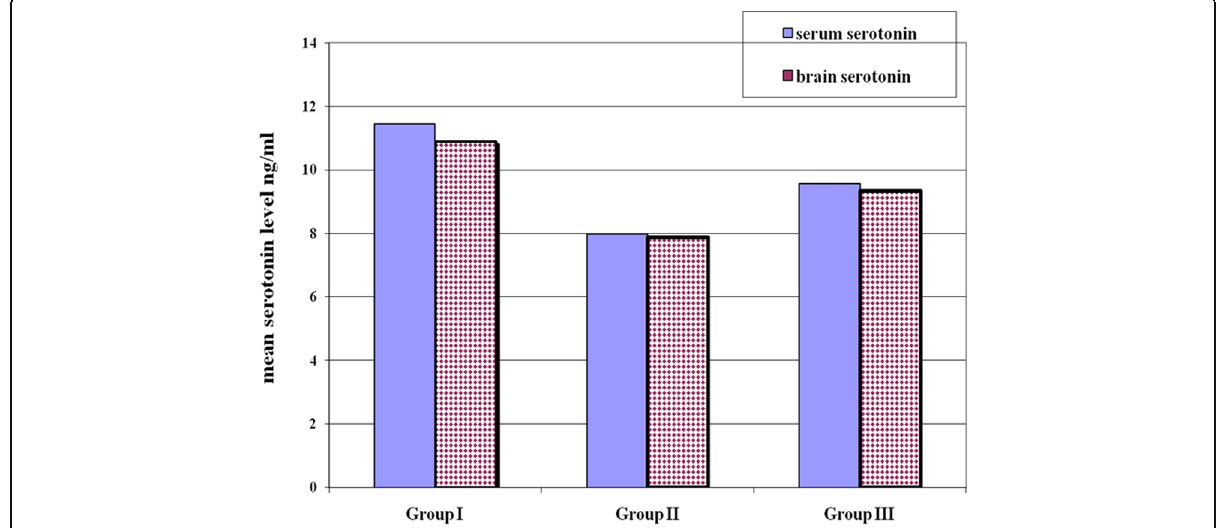
Fig. 3 Relation between mean serotonin levels in both forebrain and serum in all the study groups (Group I (C1 & C2), Group II, Group